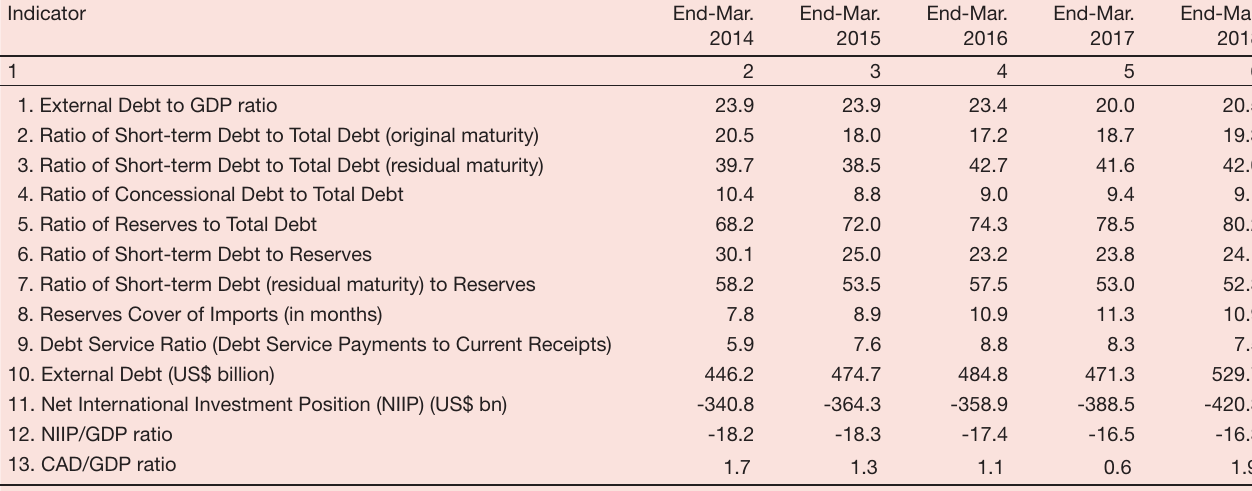
Table II.6.1: external Sector Vulnerability